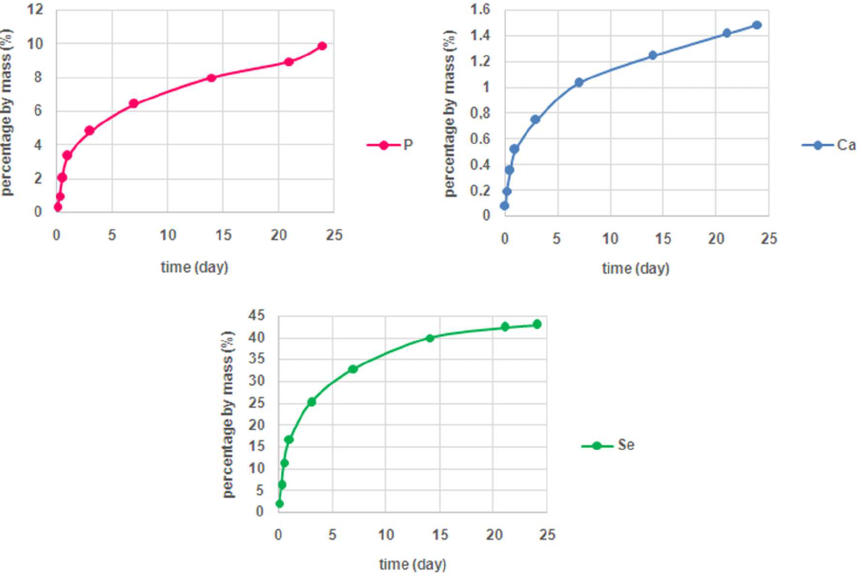
Figure 5. The release kinetics of the elements eluted from